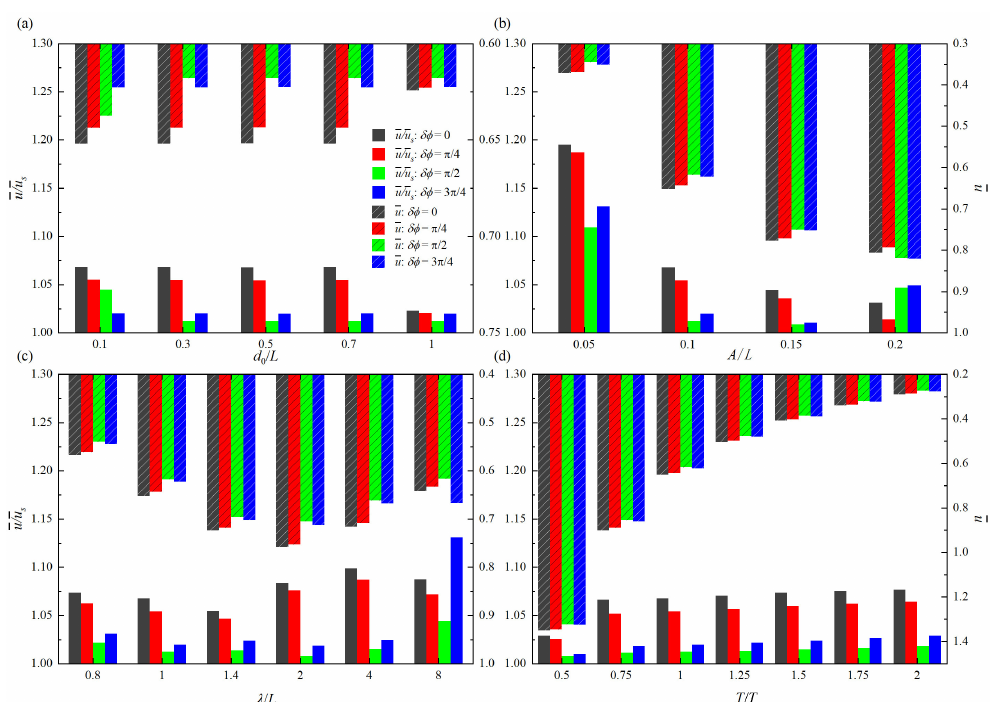
Figure 3. Mean swimming speeds with different ( a ) initial separation distance d 0 , ( b ) tail beat amplitude A , ( c ) wave length λ , and ( d ) period of oscillation T